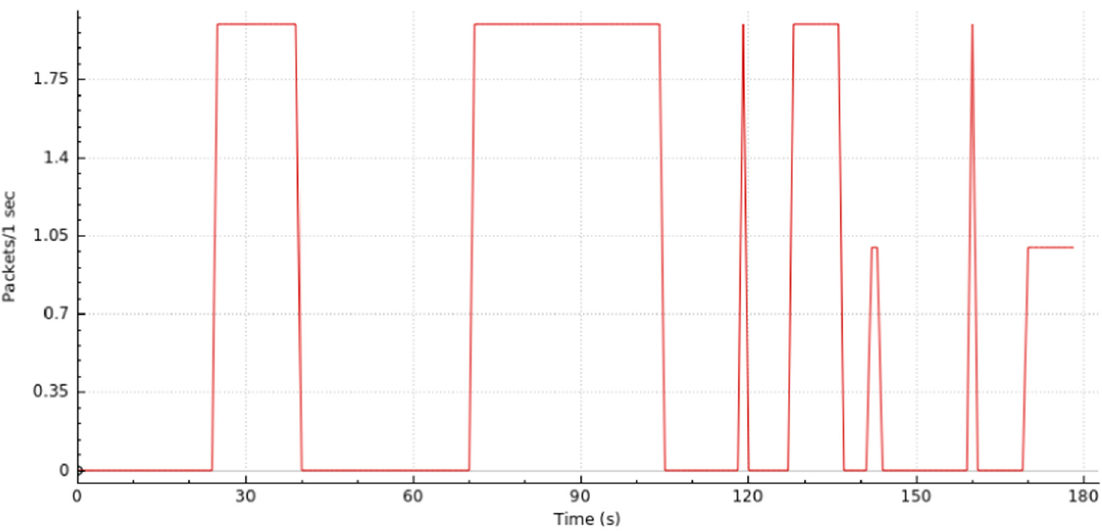
Figure 9. Scenario I—Host 2 Rate when the Remote Server is Under a DDoS Attack.